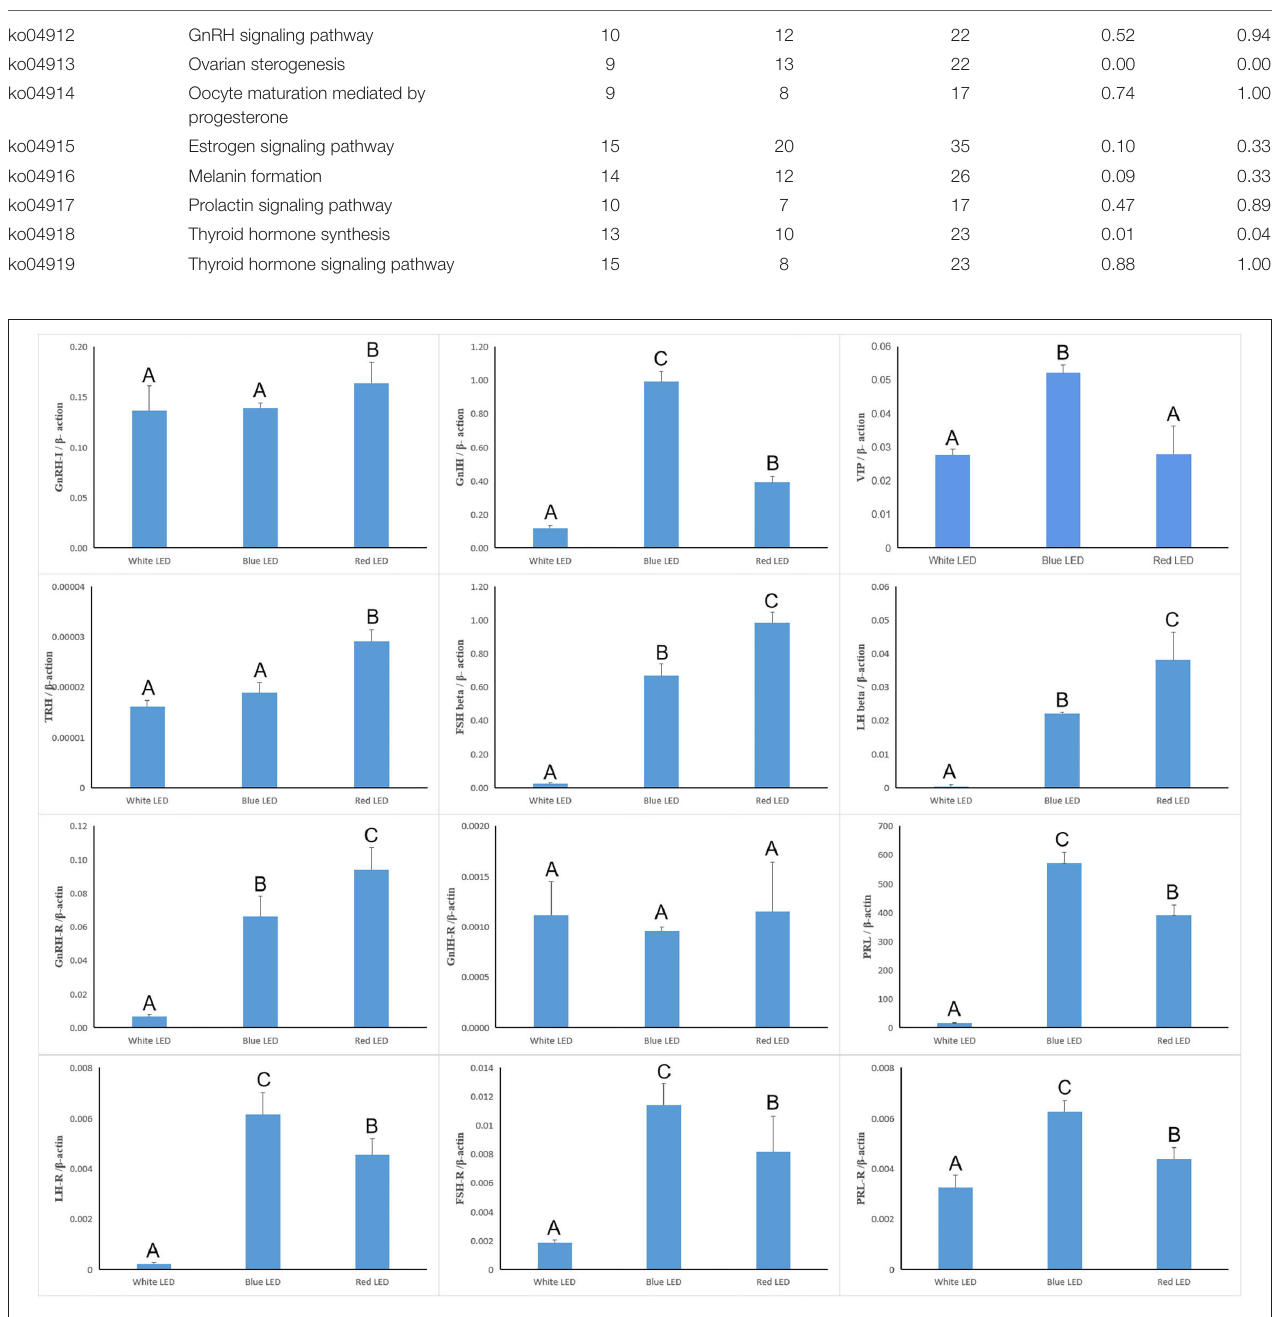
FIGURE 5 | Real-time quantitative PCR of reproduction-related genes. The A–C letters indicate significant differences at 0.05 level.